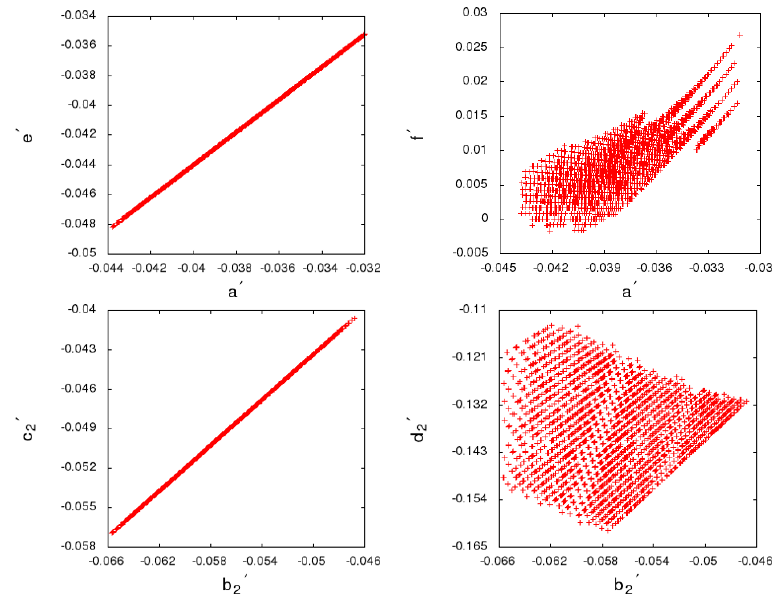
Figure 3 . Case-II: plots of the primed parameters for a normal mass hierarchy.